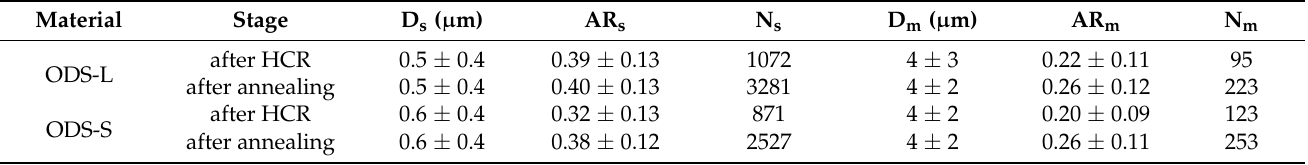
Figure 7. ( a – d ) Grain size distributions and ( e – h ) aspect ratios measured from UGC maps on submicrometric (<2 µm) and micrometric (>2 µm) sized grains for the ODS-L and ODS-S steels after HCR ( a , c , e , g ) and after annealing at 1273 K ( b , d , f , h ). Table 2. Summary of EBSD results for the ODS-L and ODS-S steels: mean size (D s ), aspect ratio (AR s ), and number of grains (N s ) for grain sizes <2 µm and for grain sizes >2 µm (D m , AR m , and N m , respectively).